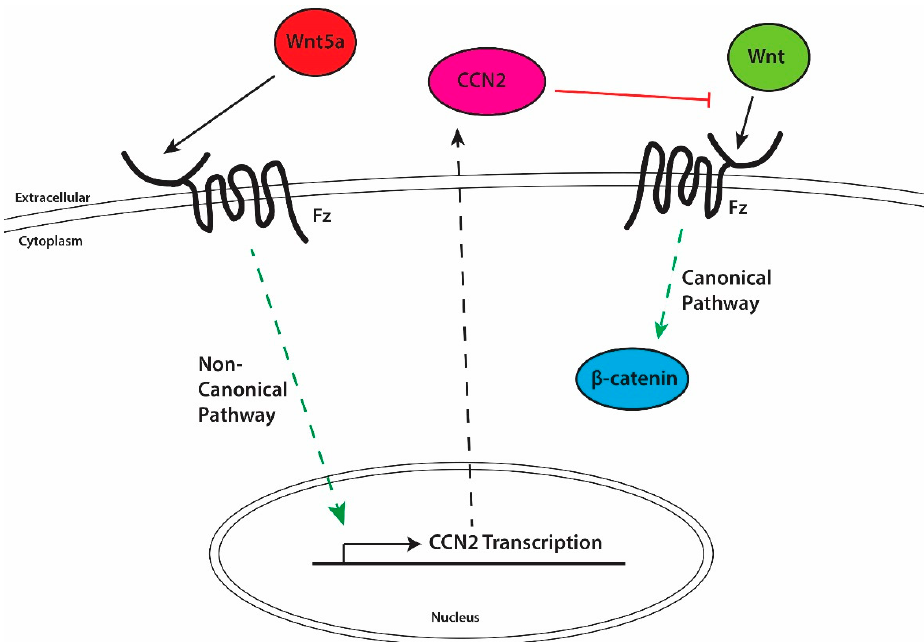
Figure 4. The role of CCN2 in regulation of LRP5/6 dependent Wnt signaling. Wnt5a signals through Fz to induce CCN2 transcription via the non-canonical Wnt pathway. Once secreted into the extracellular environment, CCN2 then inhibits other Wnt signaling to reduce canonical Wnt signaling. Absence of either Wnt5a or CCN2 results in possible over activation of canonical Wnt signaling.